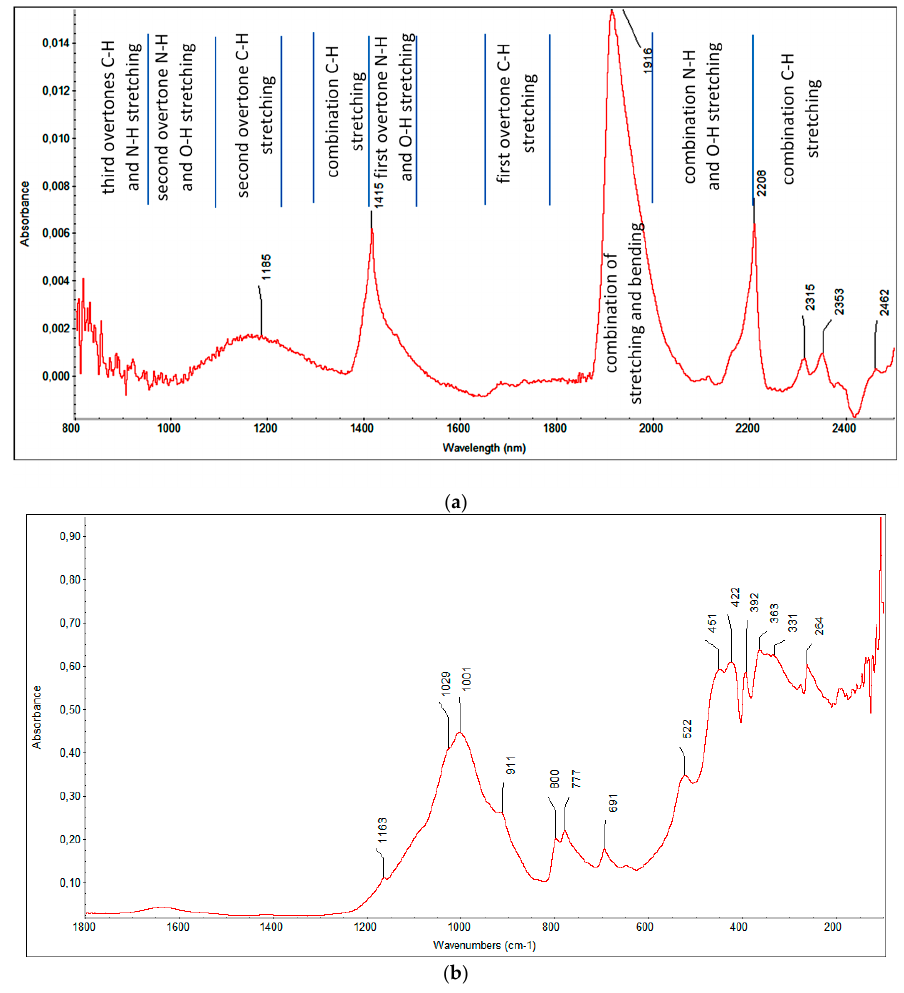
Figure 4. Exemplary ( a ) near infrared (NIR) and ( b ) far infrared (FIR) spectra.